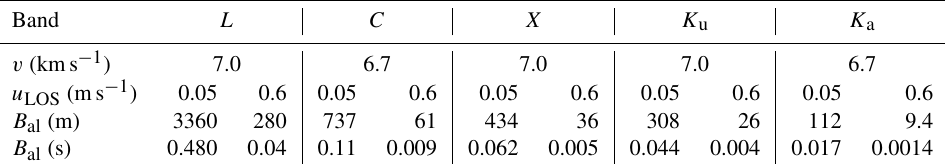
Table 5. Critical along-track spatial and temporal baselines ( B al ) causing phase shifts corresponding to a height change of 0.5m at a height of ambiguity of 5 m, calculated for small and large sea ice drift with the sensor configurations from Table 1 ( v is platform velocity over ground; u LOS is line of sight velocity of the ice). Assumptions: p = 1, phase difference per fringe (cid:49)φ mov / 2 π = 36 ◦ . Because of lacking information we used a velocity over ground of 7kms − 1 for